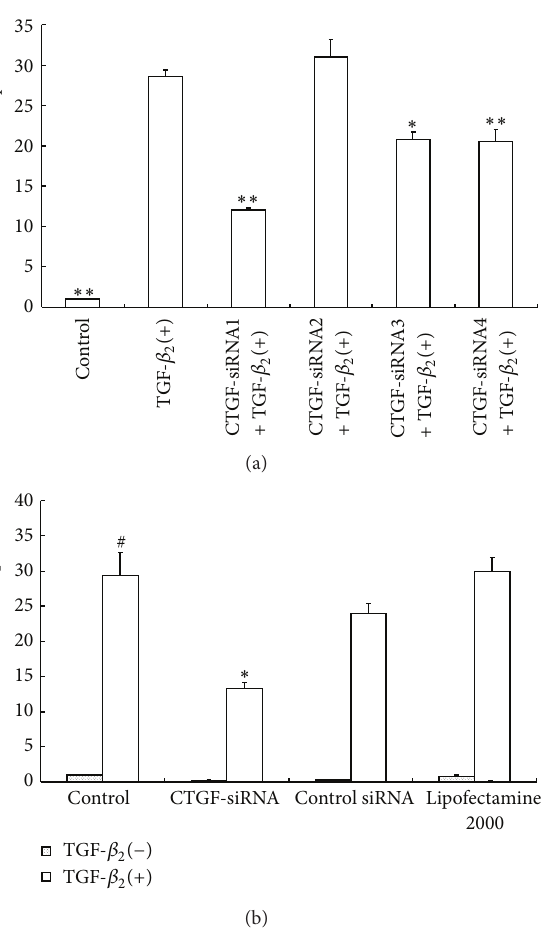
Figure 3: siRNA inhibition of CTGF mRNA expression. Serum starved HTFs were transfected with CTGF-siRNAs (siRNA1– siRNA5) or control siRNA, respectively, before being stimulated with TGF- 𝛽 2 for 24 h. (a) Comparison of relative expression of CTGF mRNA in cultured HTFs transfected with different siRNAs. Data were from three experiments. ∗ 𝑃 < 0.05 , ∗∗ 𝑃 < 0.01 versus TGF- 𝛽 2 (+). (b) Comparison of transcription levels of CTGF in HTFsunderdifferentconditions.Datawerefromthreeexperiments. # 𝑃 < 0.01 versus HTFs stimulated without TGF- 𝛽 2 in control group. ∗ 𝑃 < 0.01 versus HTFs treated with TGF- 𝛽 2